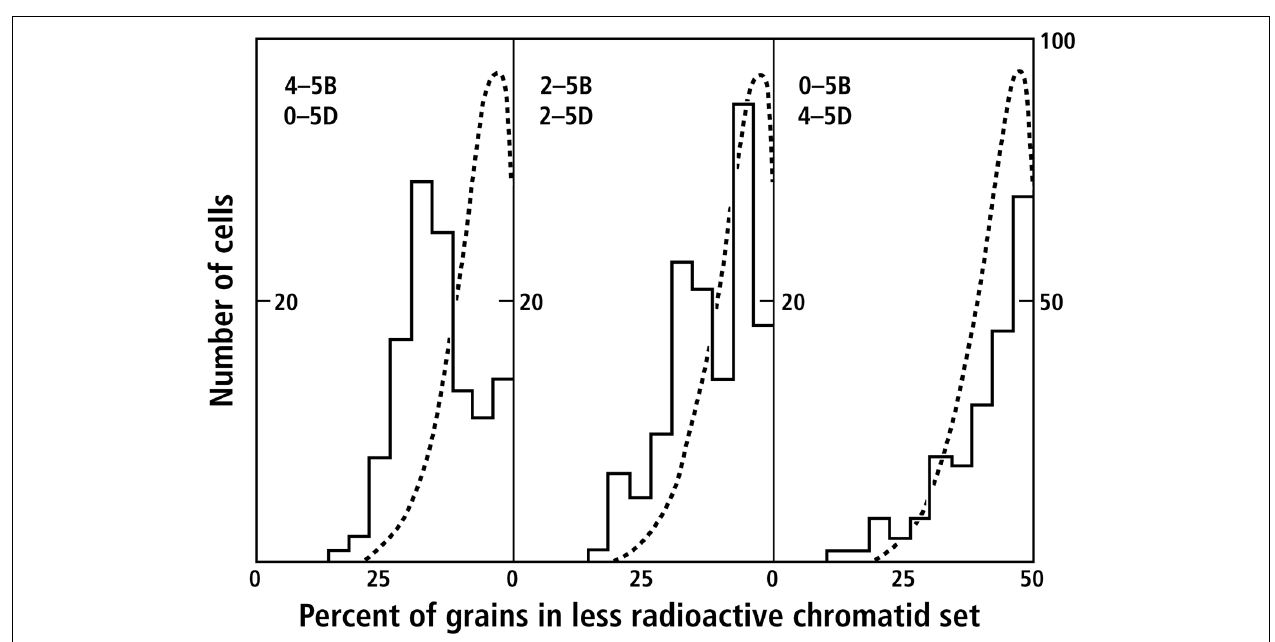
radioactive chromatid set during anaphase or telophase. Deviation to the left of 50% indicates the degree of asymmetry.The dashed curve represents the expected binomial distribution for random segregation (for details, see Lark,